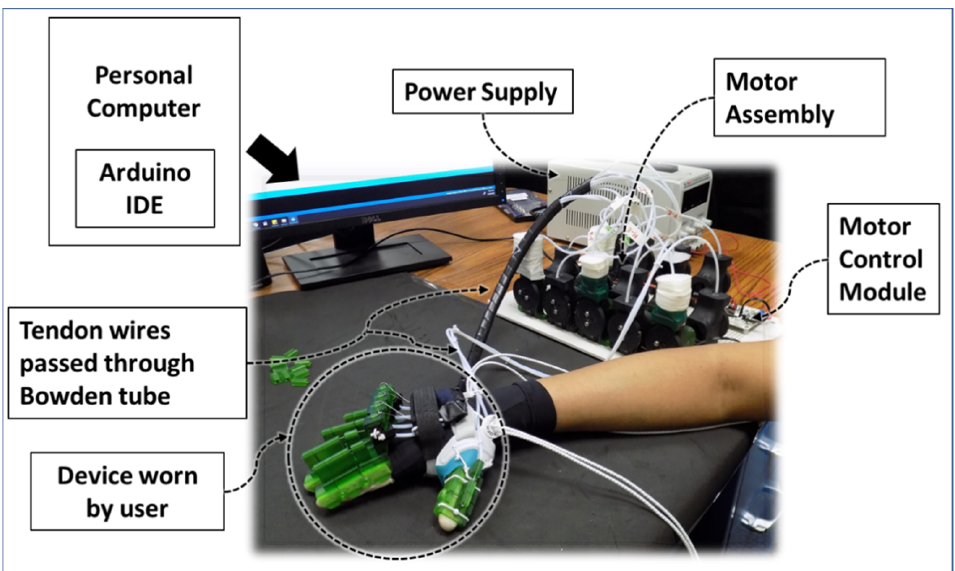
Figure 14. Schematic of the experimental setup.